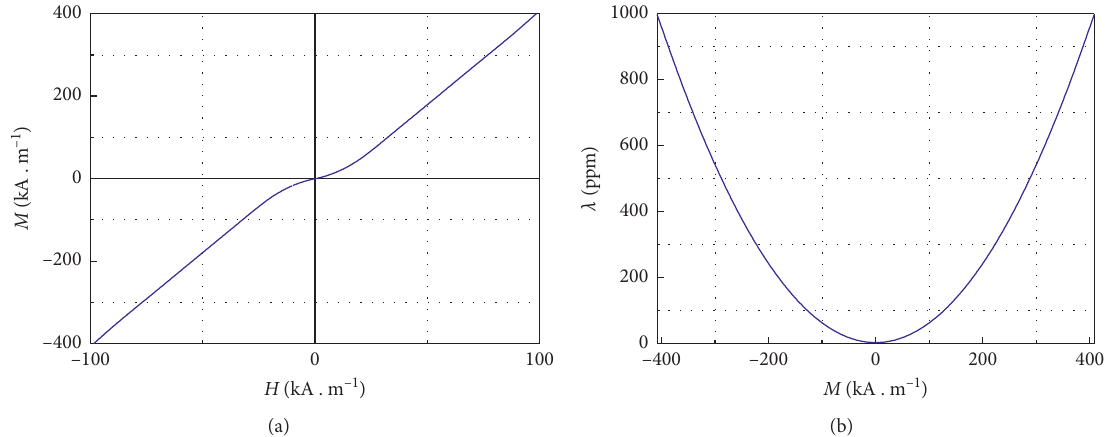
Figure 8: Magnetization model and magnetostrictive model curve. (a) Magnetic field intensity-magnetization.(b) Magnetization-mag- netostriction coefficient.